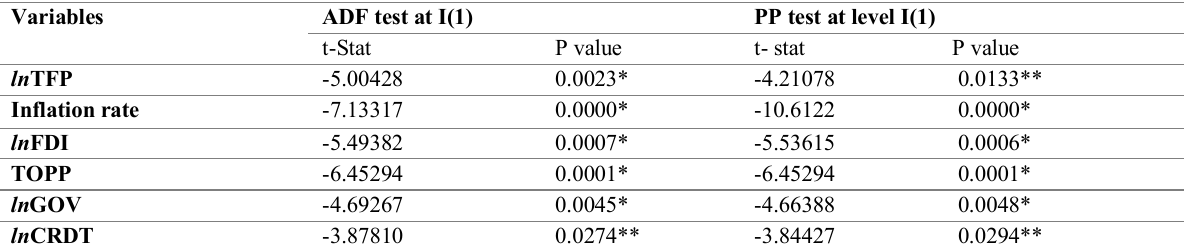
Table 2: Unit root test results of ADF and PP test at level I(1)